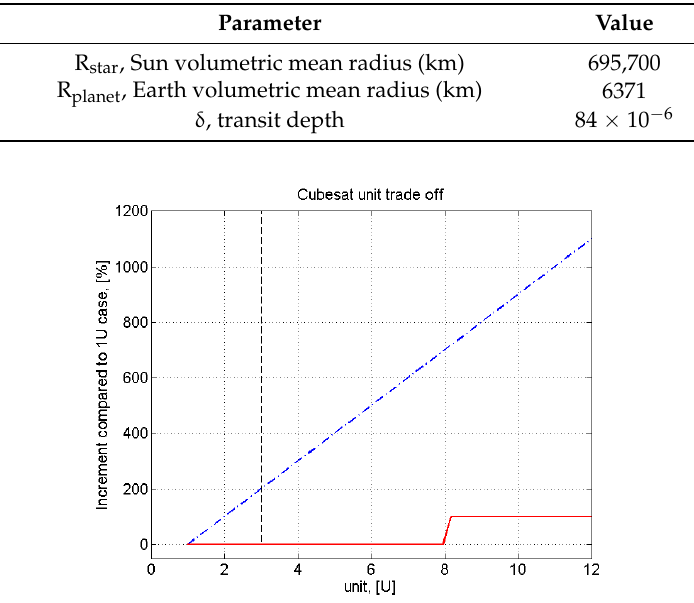
Table 2. Sun and Earth radius, expected transit depth of an Earth-like planet around a Sun-like star.